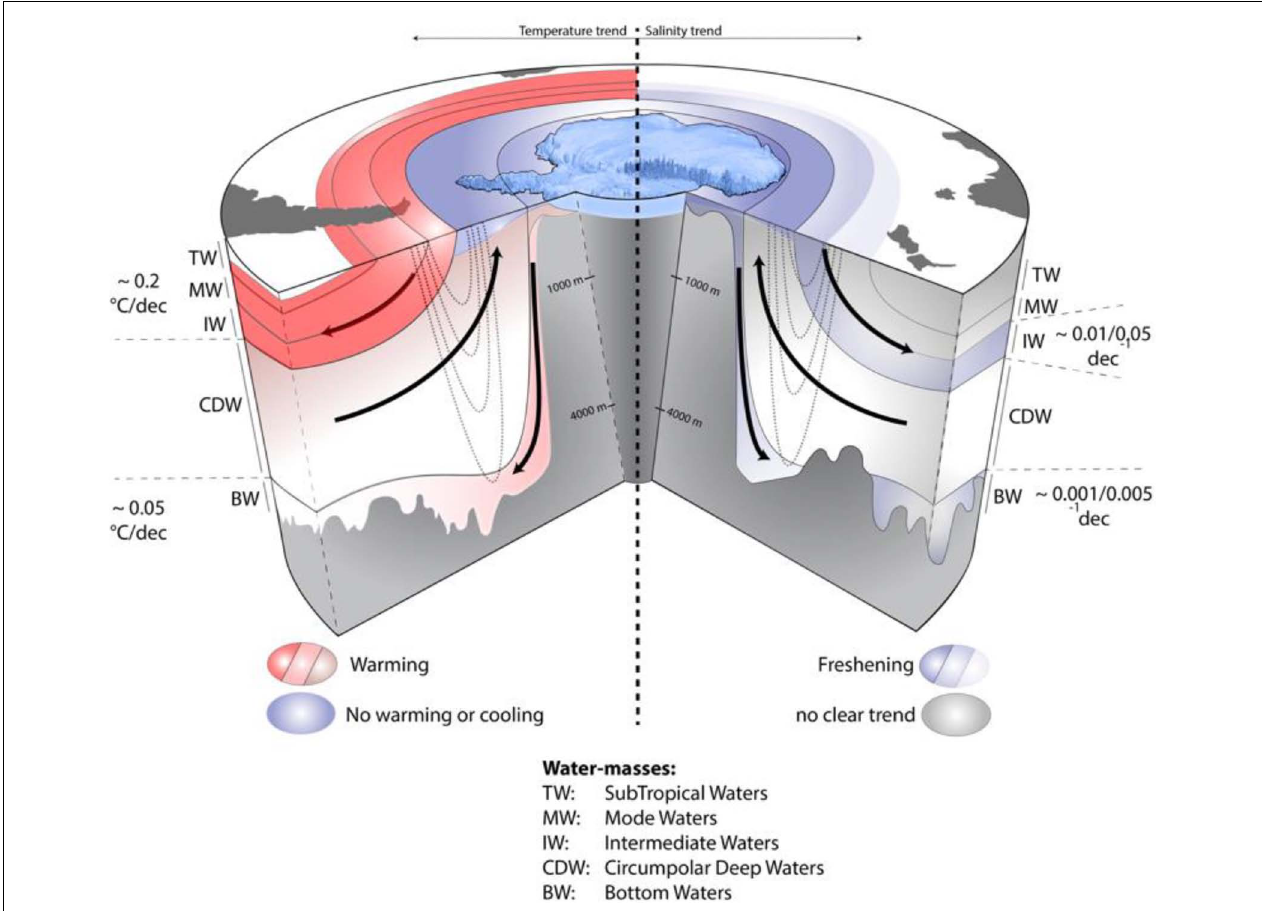
FIGURE 8 | Schematic showing temperature and salinity trends in different layers of the Southern Ocean. The layers are defined as main water-masses of the Southern Ocean: subtropical water (TW), mode water (MW), intermediate water (IW), circumpolar deep water (CDW), and bottom water (BW). Black arrows show the main overturning pathways in the basin, and the dashed black contours show a vertical slice of the deep-reaching Antarctic Circumpolar Current circulating clockwise around the Antarctic continent. Adapted from Sallée (2018, Figure